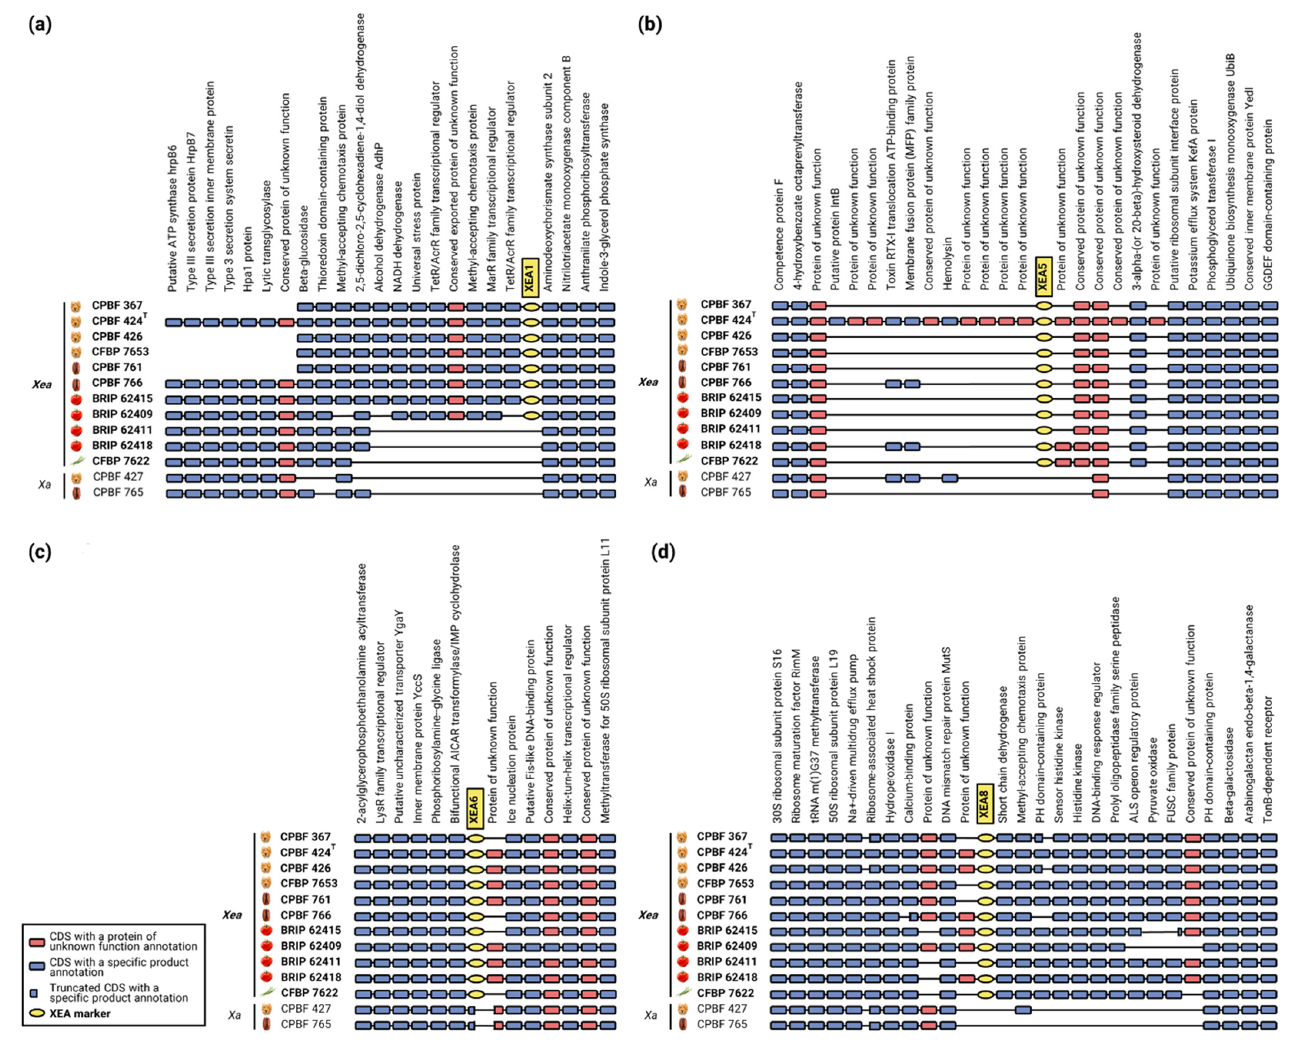
Figure 4. Comparative syntenic maps of four Xanthomonas euroxanthea -specific DNA marker- harboring-regions ( a ) XEA1 (designed from a conserved protein of unknown function sequence), ( b ) XEA5 (design from a MarR family transcriptional regulator), ( c ) XEA6 (designed from a conserved protein of unknown function sequence) and ( d ) XEA8 (designed from a protein of unknown function and a TetR/AcrR family transcriptional regulator sequences) DNA markers across 11 X. euroxanthea ( Xea ) and two Xanthomonas arboricola (Xa) strains.